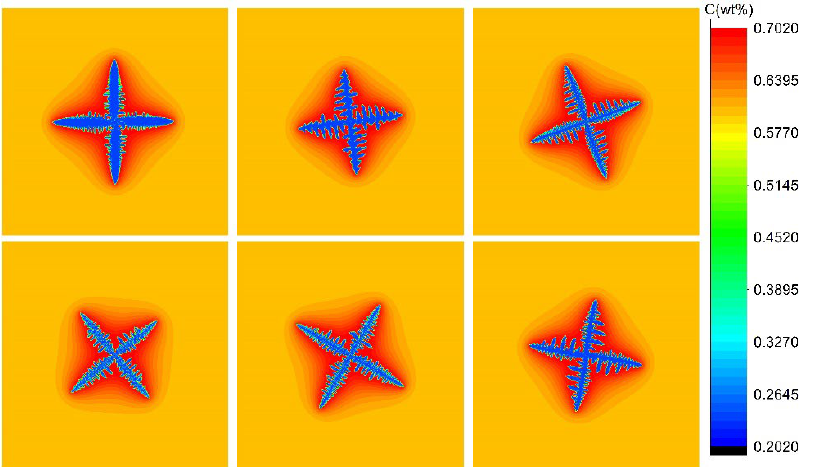
Figure 6. Solute profile and morphology of the equiaxed dendrite at the melt undercooling of 8 K as the orientation is ( a ) 0°, ( b ) 5°, ( c ) 20°, ( d ) 40°, ( e ) 60°, and ( f ) 80°.